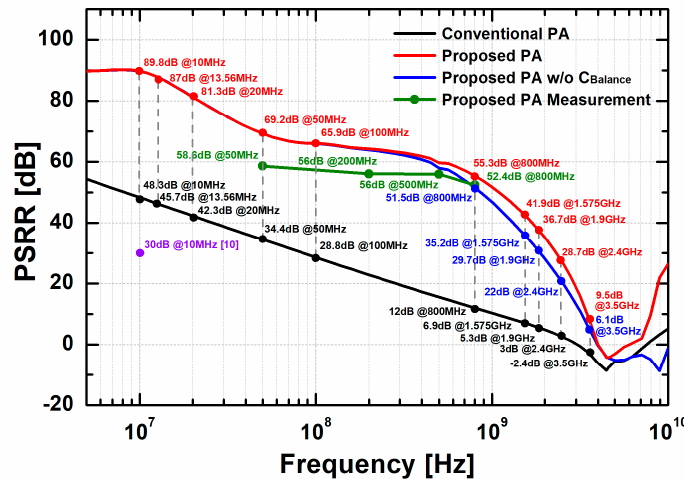
Figure 3. The simulated power supply rejection ratio (PSRR) of a conventional PA, the proposed PA (excluding C Balance ), and the simulated and measured PSRR of the proposed PA as a function of frequency, with the reported PSRR of the radio frequency (RF) of the PA in [10].